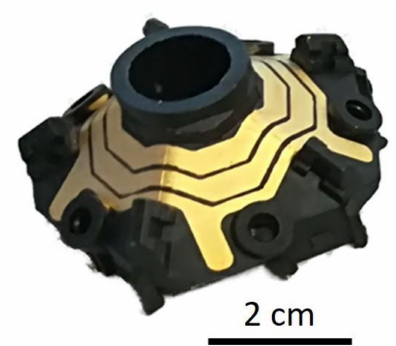
Figure 16. 3D MID item after SSAIL procedure, using pulse interlacing